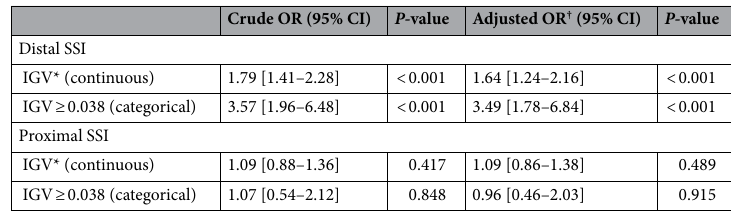
Crude OR (95% CI) P- value Adjusted OR † (95% CI) P-